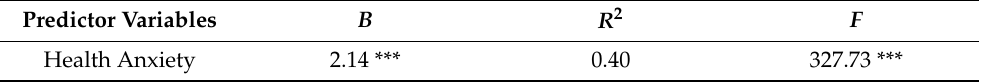
Table 2. Regression analysis for predicting cyberchondria from health anxiety ( N = 500). Predictor Variables